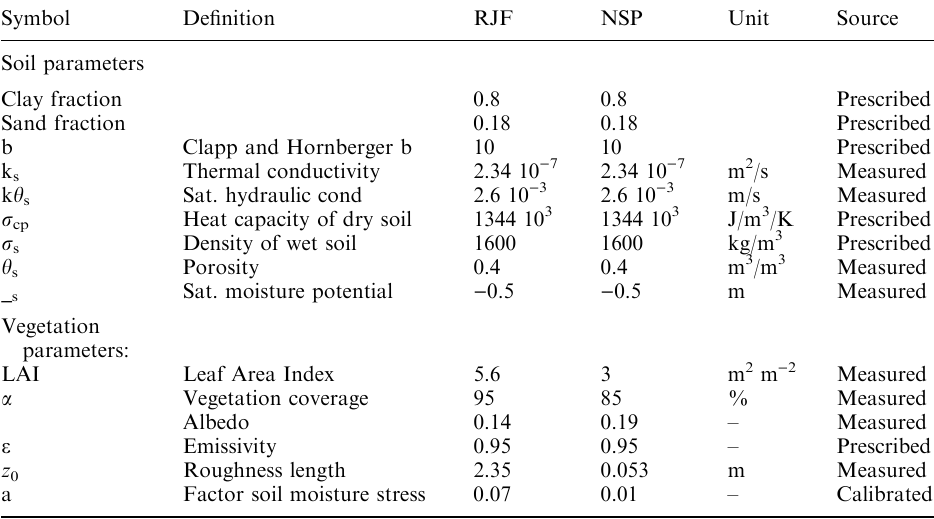
Table 2. The RAMS scheme soil and vegetation structure parameters over the Rondoˆ nia sites of ABRACOS during the dry season. The values are either prescribed, measured, calculated from continuous functions of the texture, or calibrated